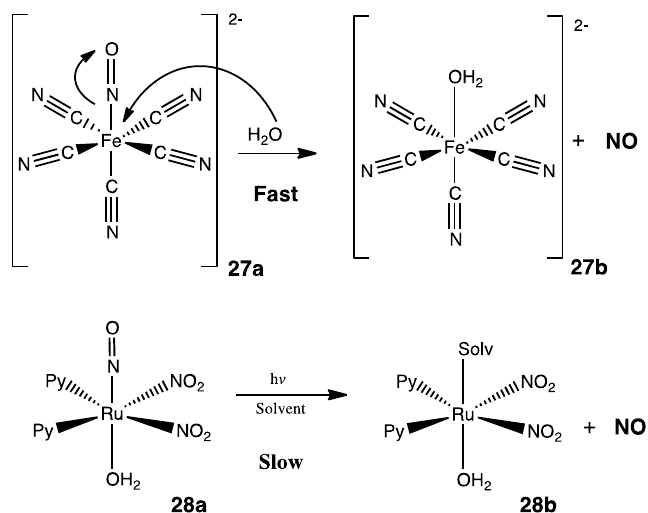
Figure 13. The mechanisms involving the realization of ·NO in coordination complexes [43,51].